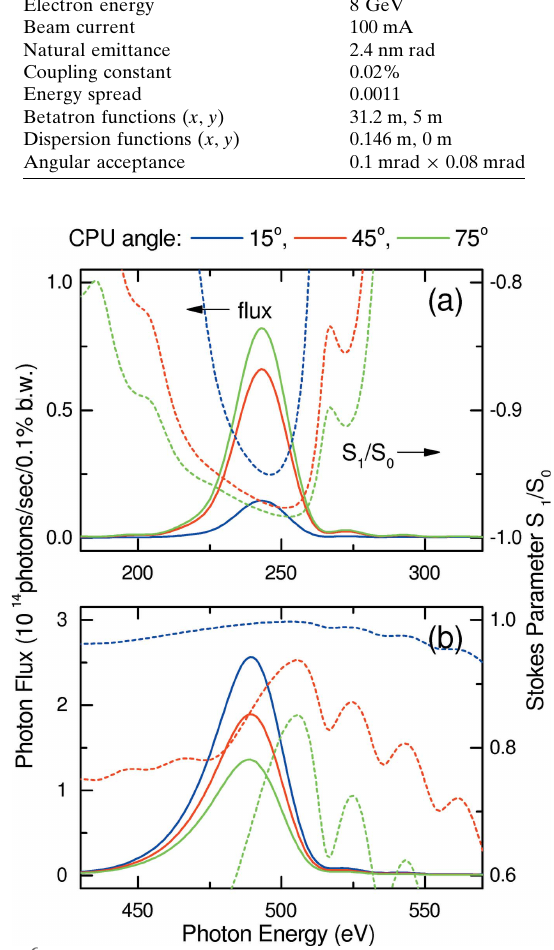
Figure 6 Comparison of light source performances between three different CPU angles: ( a ) 0.5th-harmonic and ( b ) fundamental radiation. Solid and dashed lines show the photon flux and Stokes parameter,